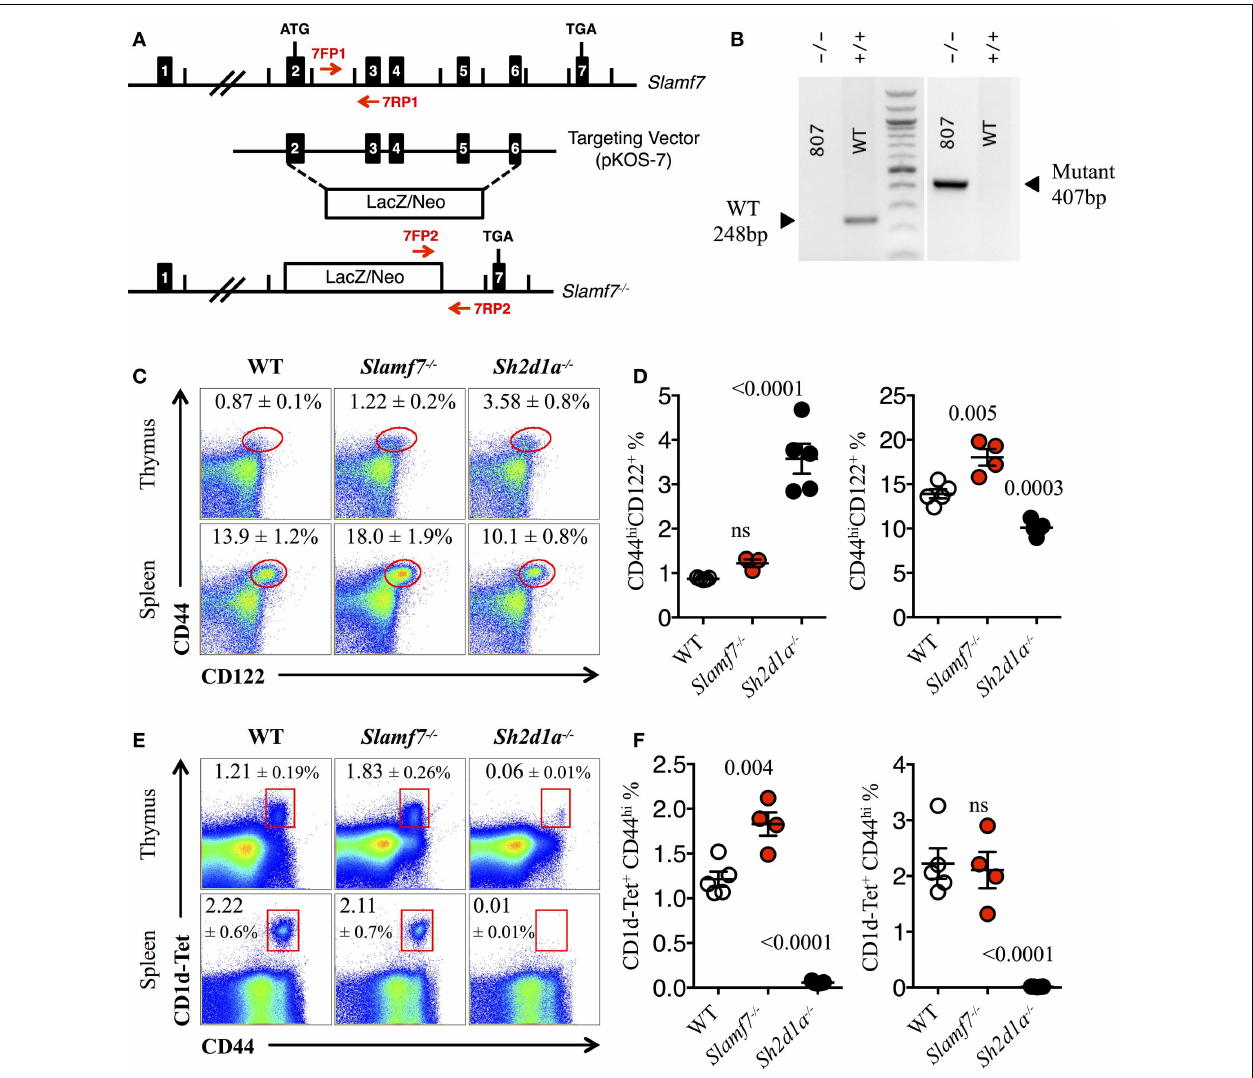
TCR β hi CD8SP ( thymus ) orTCR β + CD8SP ( spleen ). (D) Percentage of CD44 hi CD122 + CD8SPT cells in thymus ( left ) or spleen ( right ) ofWT, Slamf7 − / − or Sh2d1a − / − B6 mice. (E) Representative FACS plots showing PBS-57 CD1d-tetramer (CD1d-Tet) reactive NKT cells from thymus or spleen ofWT, Slamf7 − / − or Sh2d1a − / − B6 mice. FACS plots are gated on live singlets lymphocytes. (F) Percentage of CD1d-Tet + CD44 + cells in thymus ( left ) or spleen ( right ) ofWT, Slamf7 − / − or Sh2d1a − / − B6 mice. Numbers inside plots show the mean percentage ± SD of innate-like CD8 + T cells (C) or NKT cells (E) , mean ± SEM.The p values were calculated by unpaired t -test between theWT group and Slamf7 − / − or Sh2d1a − / − group. A value of p < 0.05 was considered significant; ns,